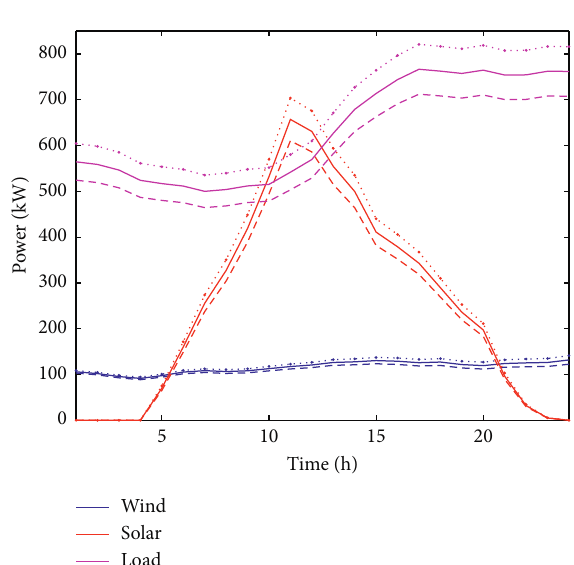
Figure 3: Fluctuation ranges of uncertain parameters with un- certainty interval set to